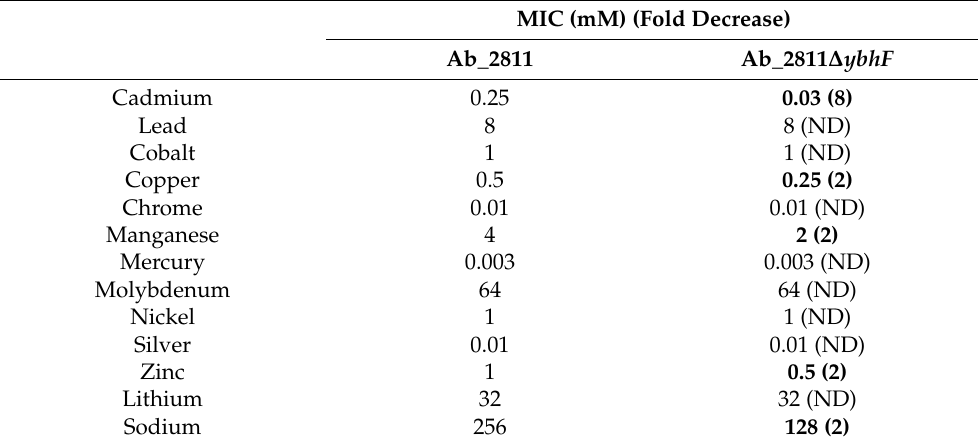
Table 2. Minimum inhibitory concentration, in mM, of metals for the parental and respective mutant strains of Aliarcobacter butzleri